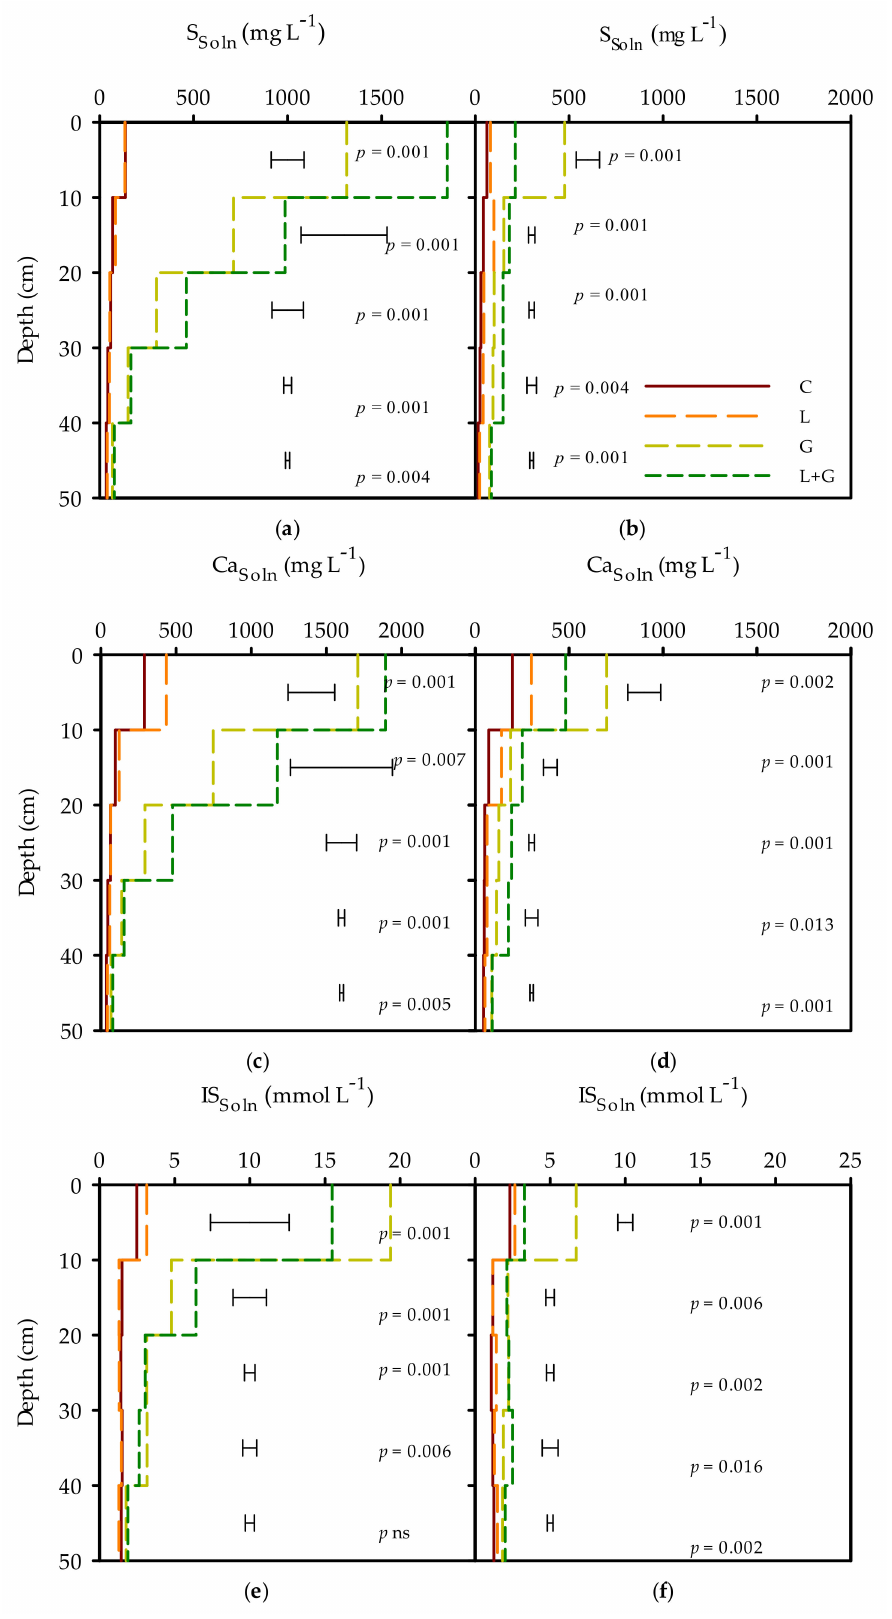
Figure 1. ( a , b ) The soil solution sulfate (SO 4 -S Soln mg L − 1 ), ( c , d ), calcium (Ca Soln , mg L − 1 ), and ( e , f ) ionic strength (IS Soln mmol L − 1 ), ( a , c , e ) in the ST ( b , d , f ) and LT ( b , d , f ) for the C, L, G, and L + G treatments. The error bars represent least significant difference values at p = 0.05, n = 3 for each depth with ns denoting p >